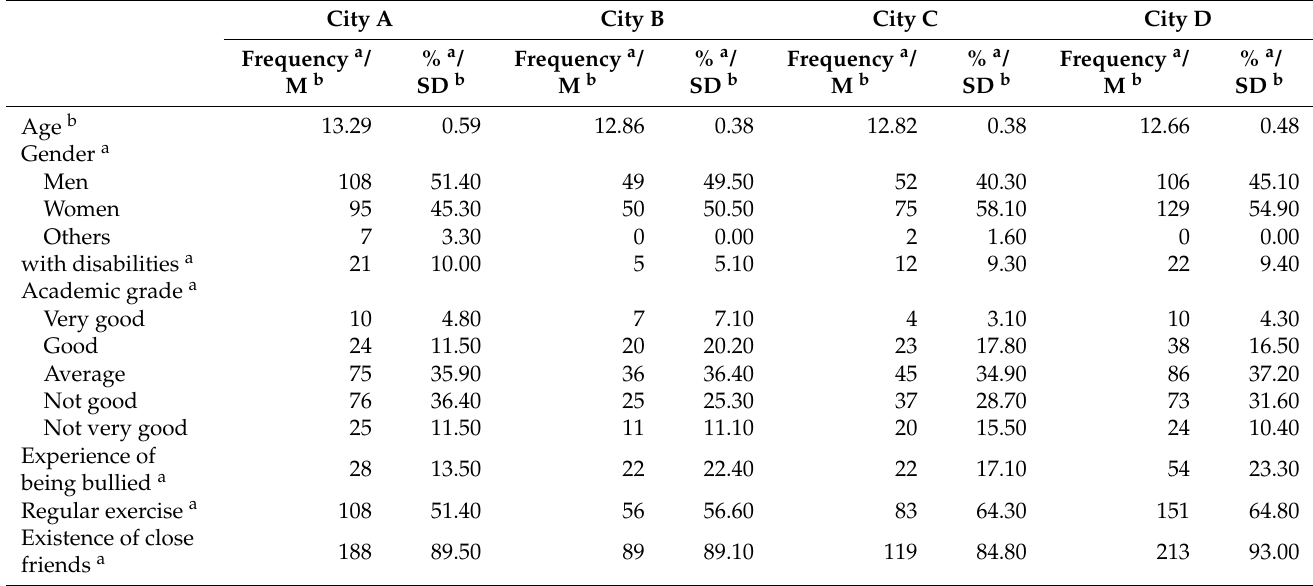
Table 1. Participants’ socio-demographic